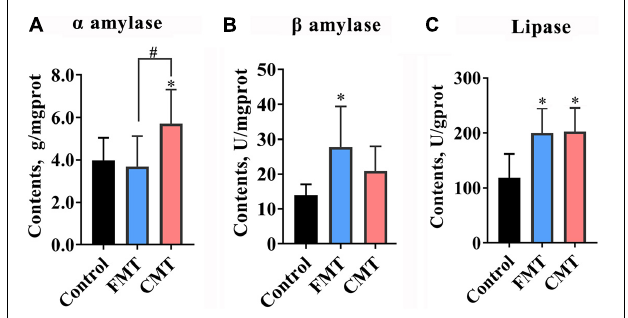
FIGURE 4 | Microbiota transplantation increased the enzyme activities of amylase and lipase in the guts of piglets. (A) CMT increase α amylase activity in piglets ( n = 6). (B) FMT increased β amylase in piglets ( n = 6). (C) Both CMT and FMT increase lipase activity ( n = 6). CMT, colonic microbiota transplantation; FMT, fecal microbiota transplantation. The data are presented as the mean ± SD. ∗ Indicates P < 0.05 compared with control; # indicates P < 0.05 between FMT and CMT.